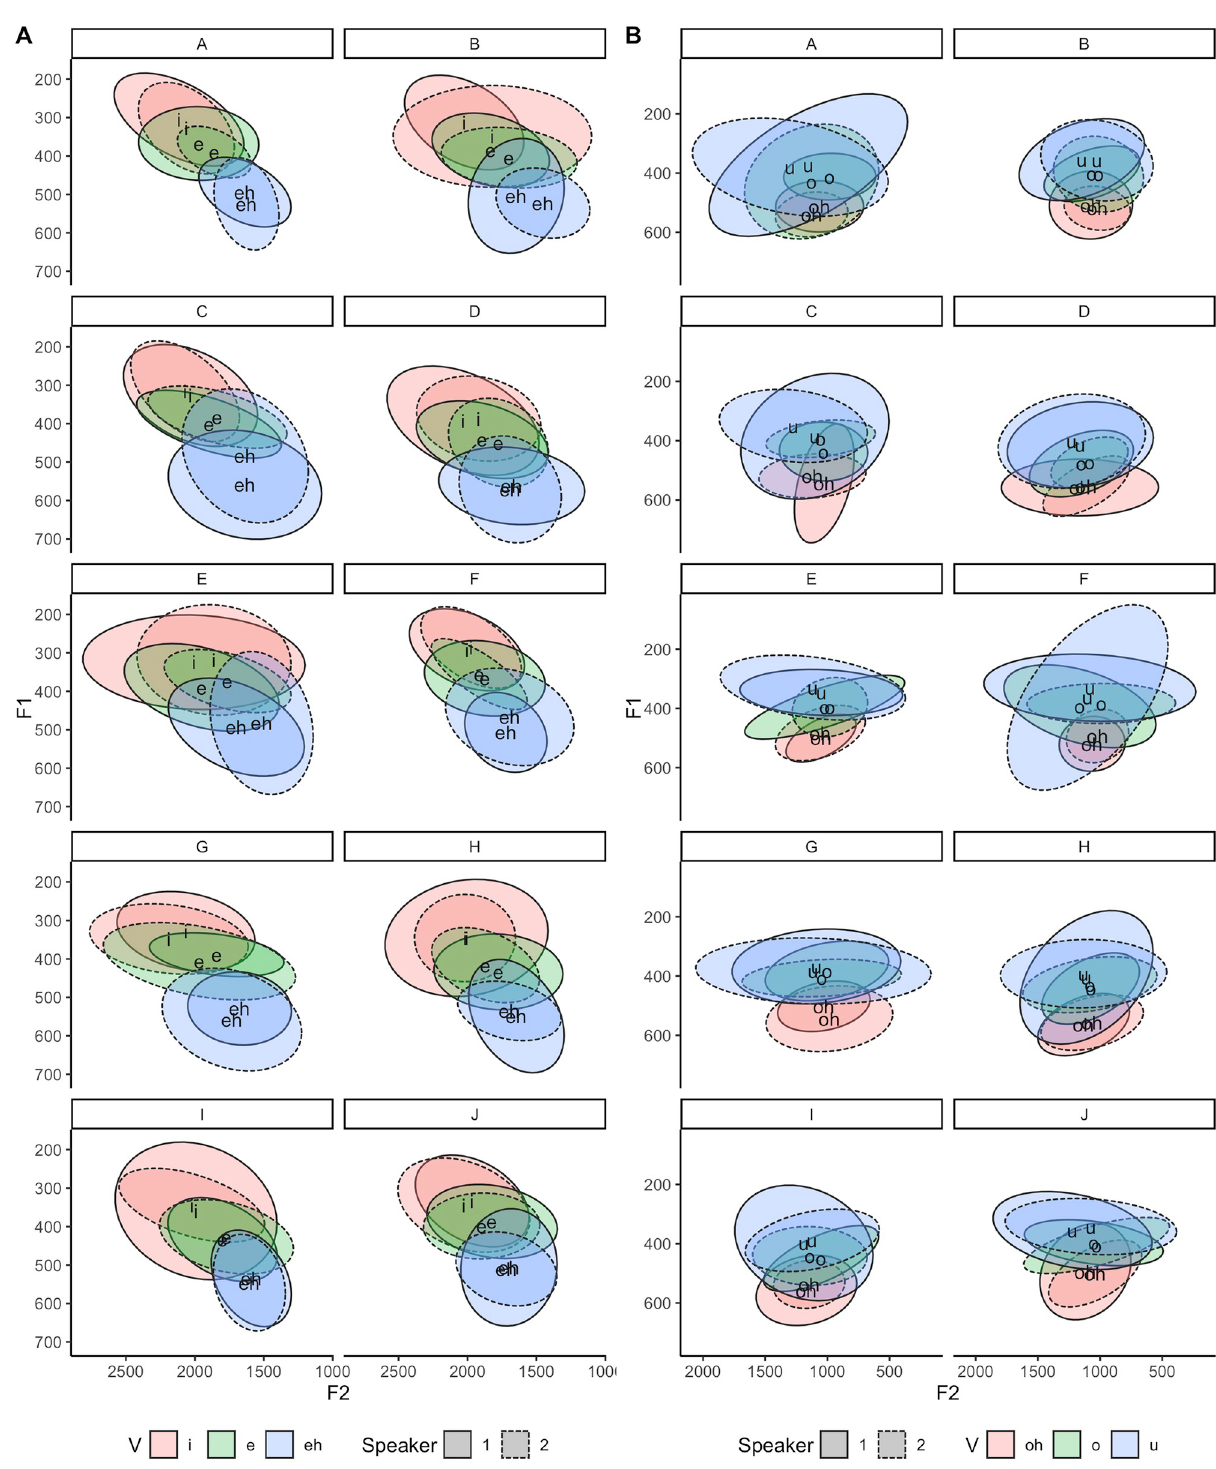
Fig 2. Front vowels (A) and back vowels (B) vocalic spaces’ means and confidence interval for intra-identical twin pairs comparisons.